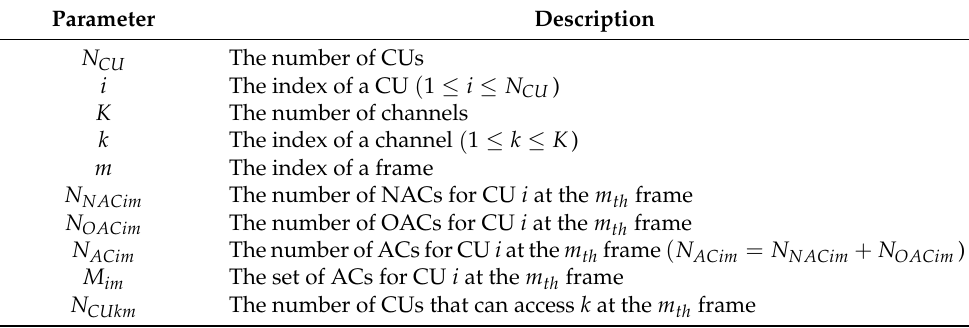
Figure 4. An example of the asymmetry of available channels in a centralized UCAN: ( a ) network configurations and channel description; ( b ) the results of Table 2. The definition of parameters to describe the asymmetry of available channels. Parameter